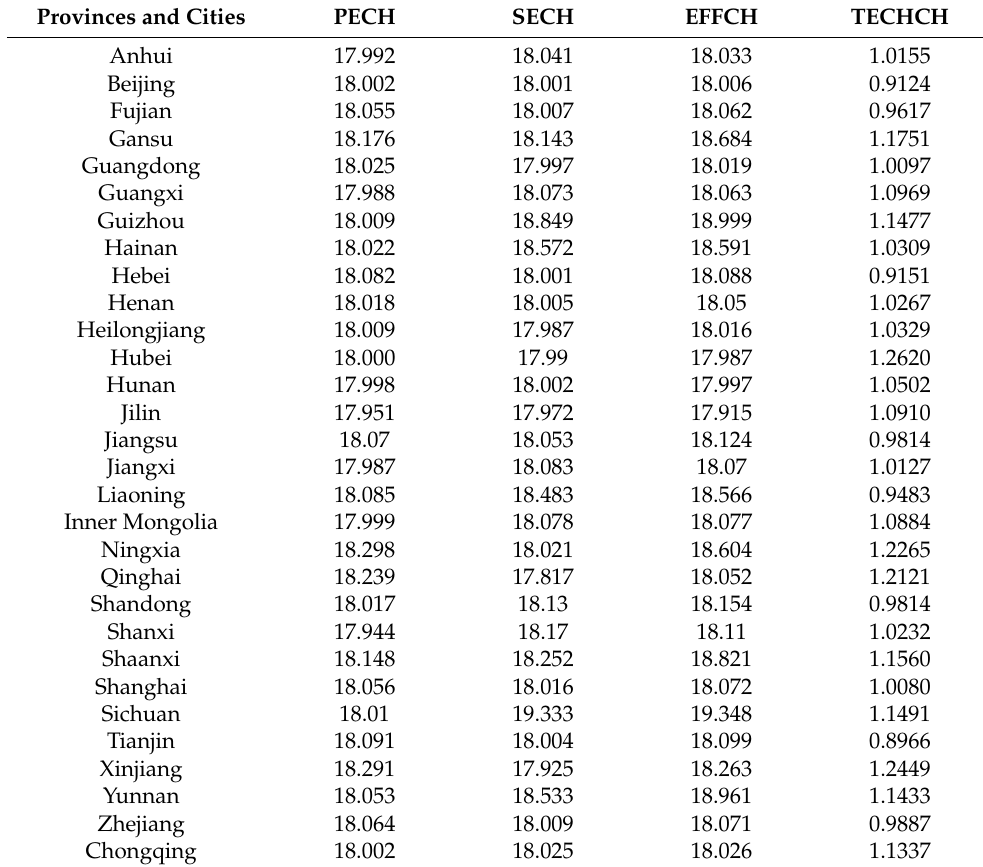
Table 1. TFP index and decomposition of annual TFP changes in 30 Provinces and cities in China (2001–2018). Provinces and Cities